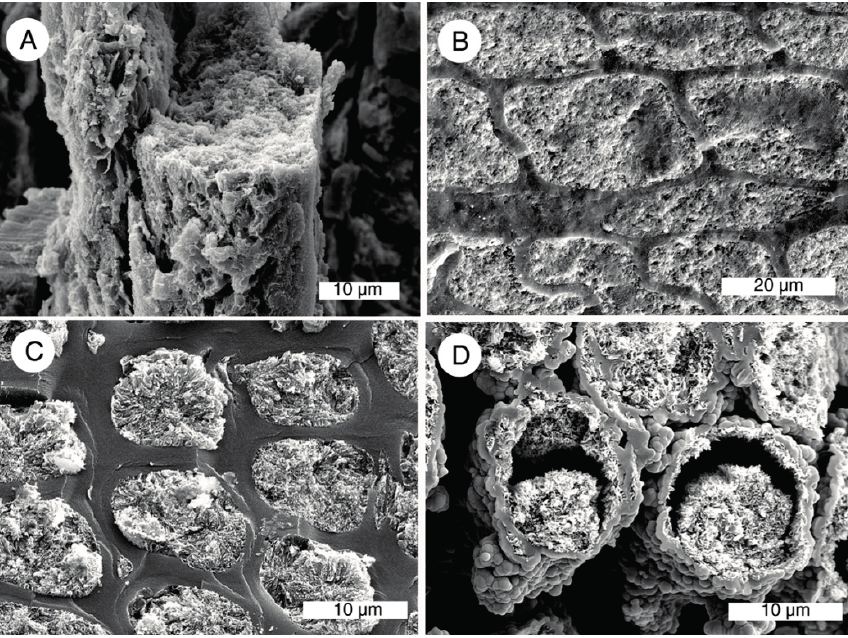
Figure 11. Porous opal in cell lumina. ( A ) Opal-CT, location 2 (Norita opal mine); ( B , C ) Opal-CT, vitreous cell walls with porous opal filling lumina, location 16; vitreous cell walls with porous opal filling lumina, location 2 (Rainbow Ridge opal mine); ( D ) Opal-A, botryoidal coatings on cell walls, with a thin porous interior layer, and porous partial filling of lumina, locality 2 (Section 27 opal